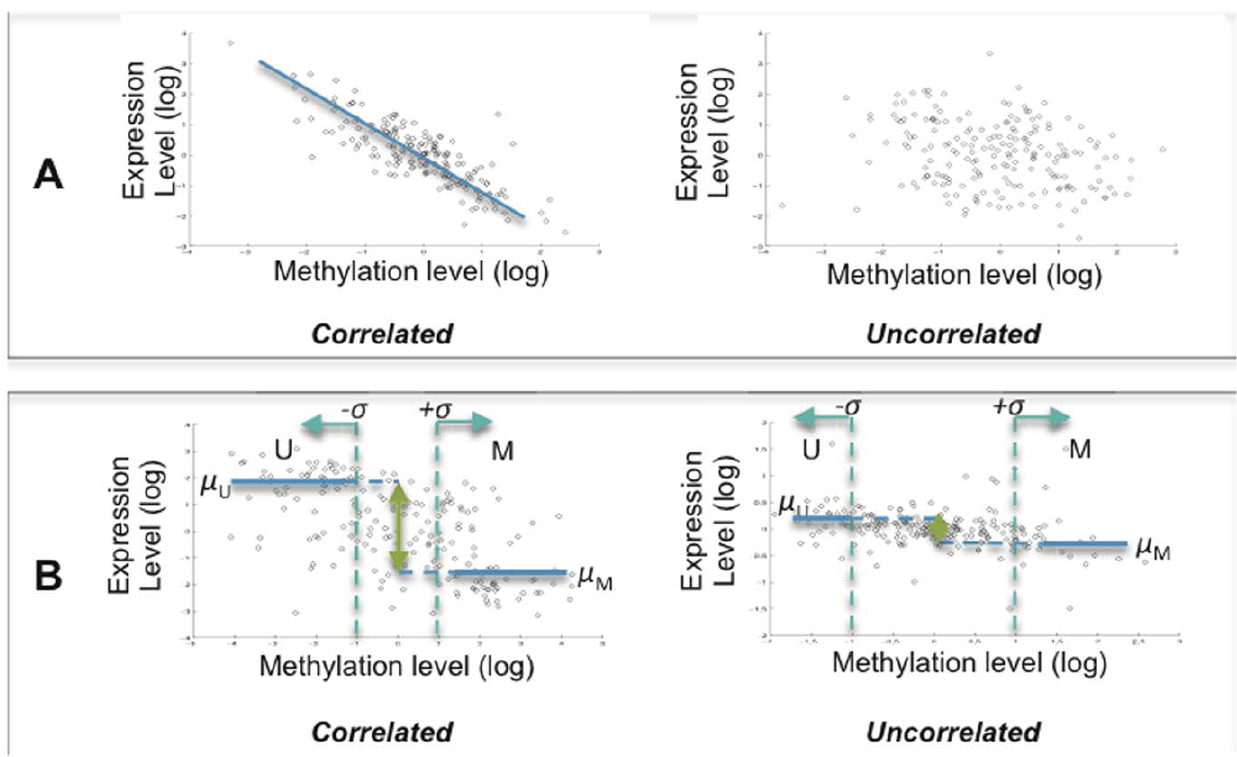
Figure 1. Methods used to identify genes with methylation-expression correlations. (A) Pearson correlation was used to measure linear relationships between DNA methylation and gene expression levels for 1505 CpG probes represented on the GoldenGate Methylation BeadArray. The panels represent examples of a gene with high (left) and low (right) Pearson correlation coefficients when analyzing DNA methylation levels (x axis) against gene expression levels (y axis). (B) A discretization approach was used to classify samples into methylated (M) or unmethylated (U) groups based on the mean ( m ) methylation value and standard deviation ( s ) of a given probe. Statistically significant gene expression differences between M and U groups indicated a methylation-expression correlation for the gene in